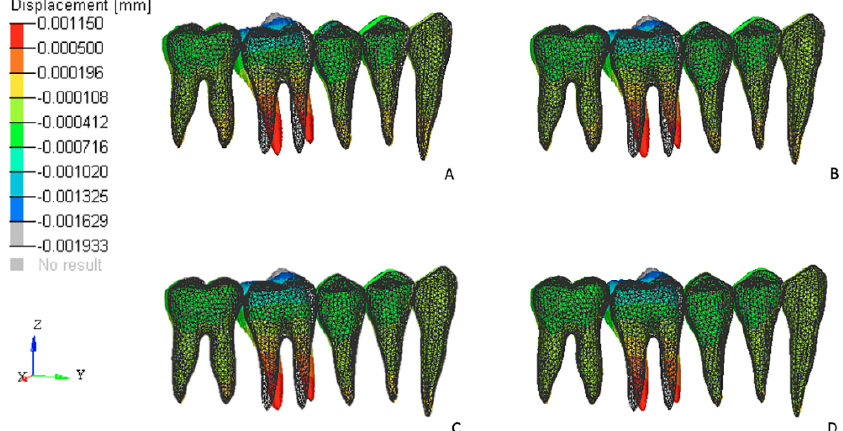
Figure 7. Initial displacement tendencies on the teeth that served as the posterior anchorage unit from a sagittal view. Teeth displacement was magnified 3000 times. Initial position (drawn) and final position (color). ( A ) FEM 1, ( B ) FEM 2, ( C ) FEM 3, and ( D ) FEM 4.